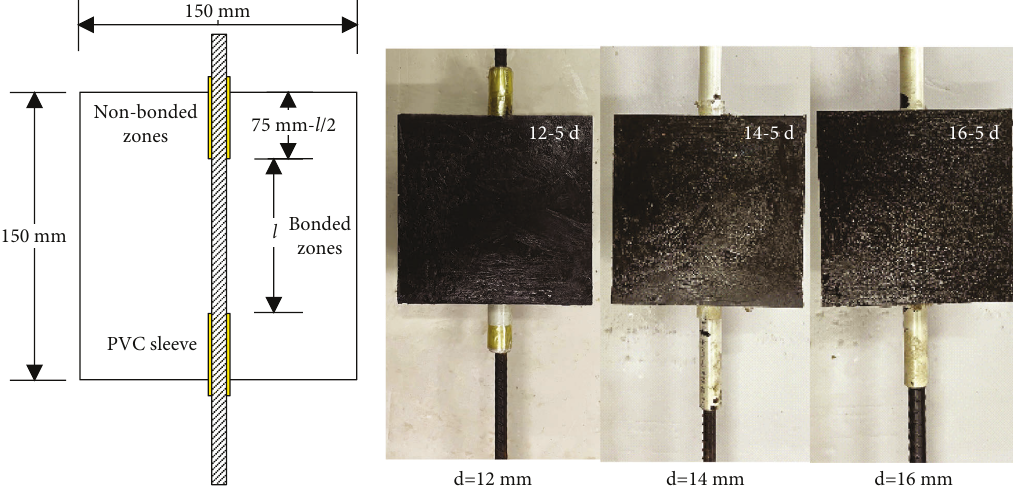
Figure 17: Pull-out specimens of steel reinforcement bonded to polyurethane concrete.